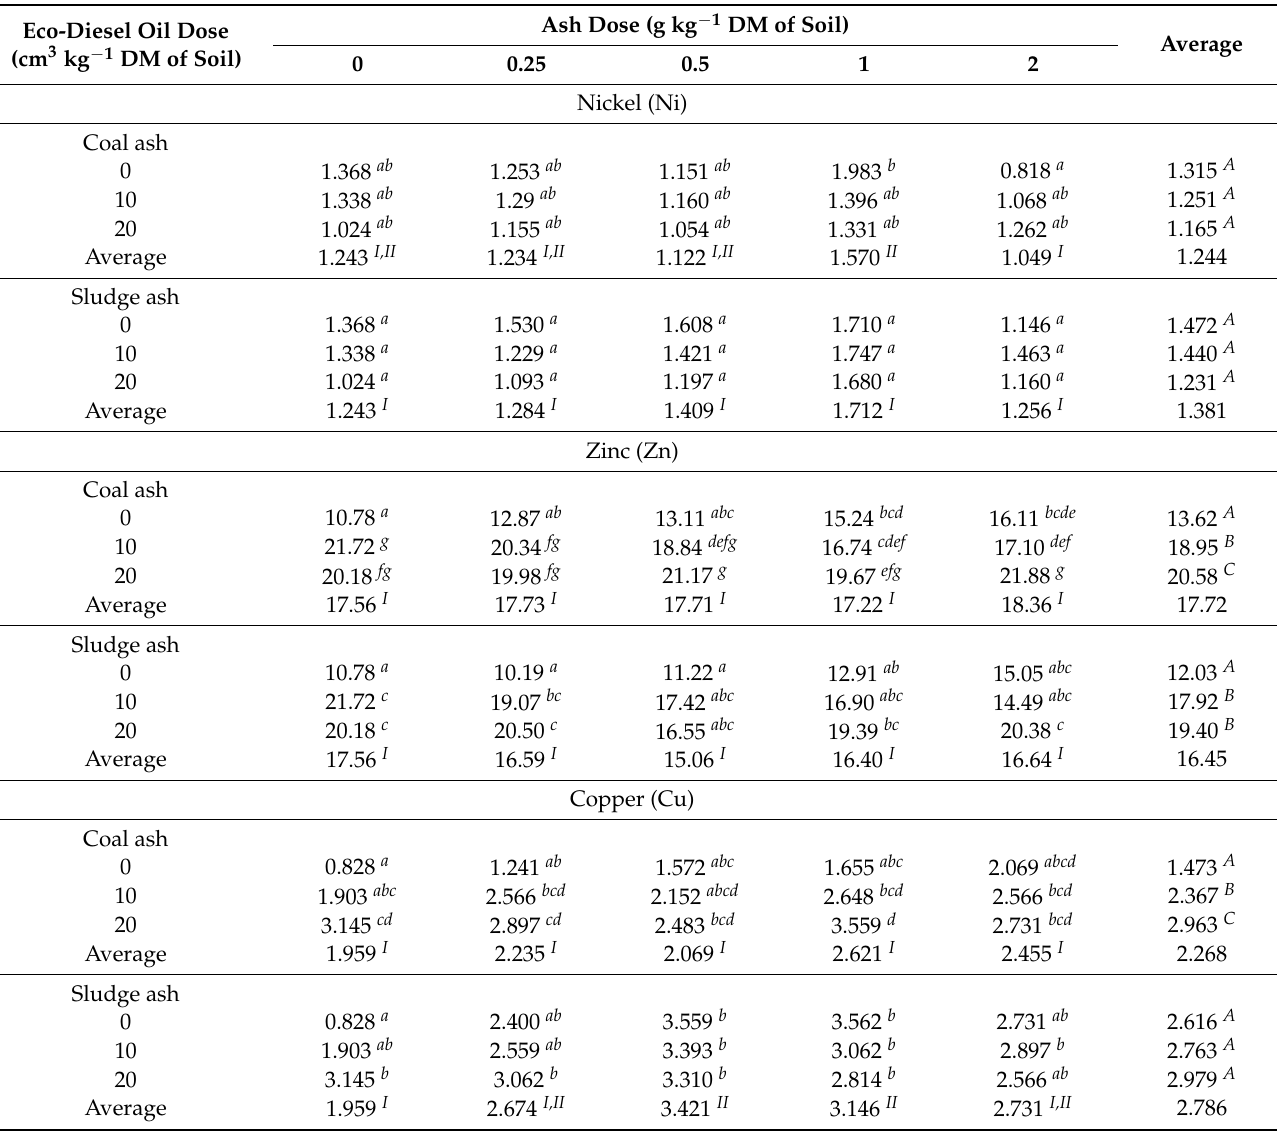
Table 2. Content of nickel (Ni) zinc (Zn), and copper (Cu) in above-ground parts of maize— Zea mays L. (mg kg − 1